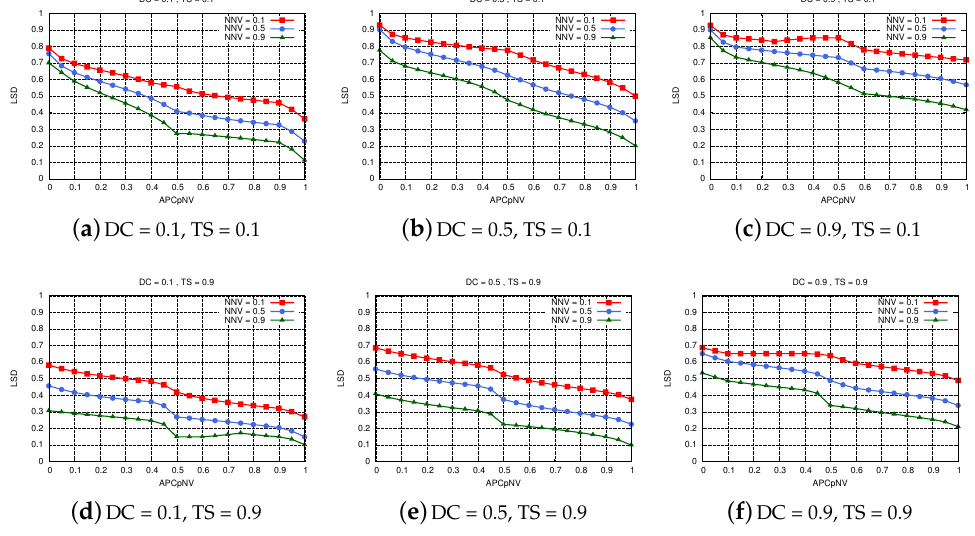
Figure 10. Simulation results for